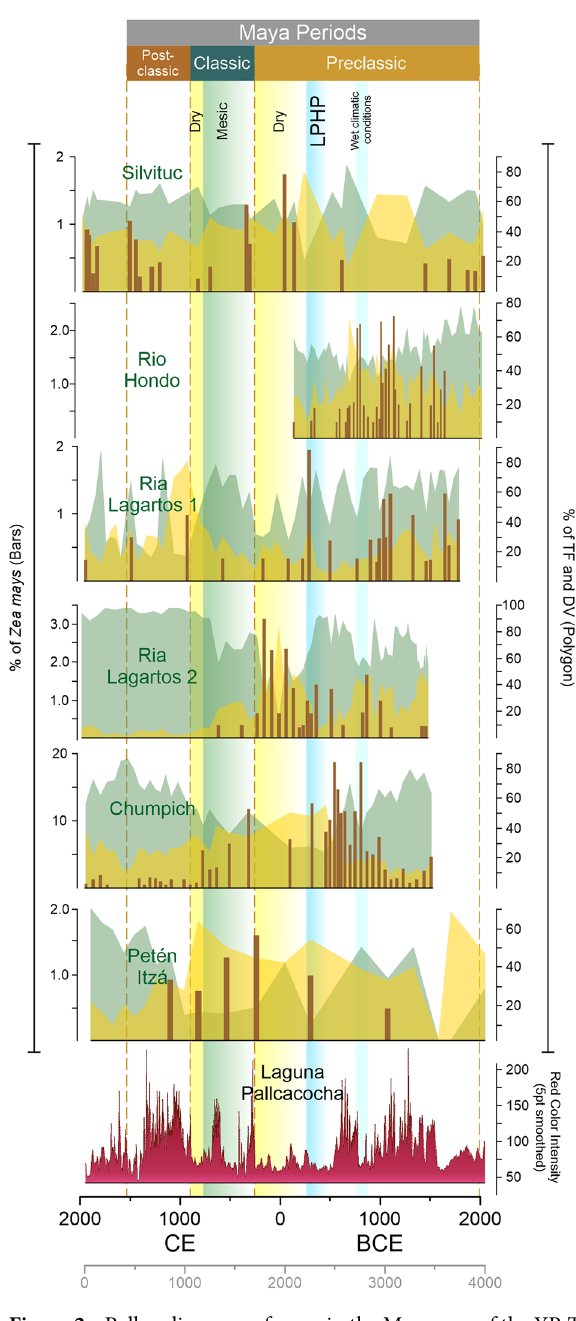
Figure 2. Pollen diagrams of cores in the Maya area of the YP. Tropical Forest (TF; shaded green) and disturbance vegetation (DV; shaded yellow) percentages along with Zea mays (brown bars) and smoothed Red Color Intensity in Laguna Pallcacocha 54 as ENSO activity